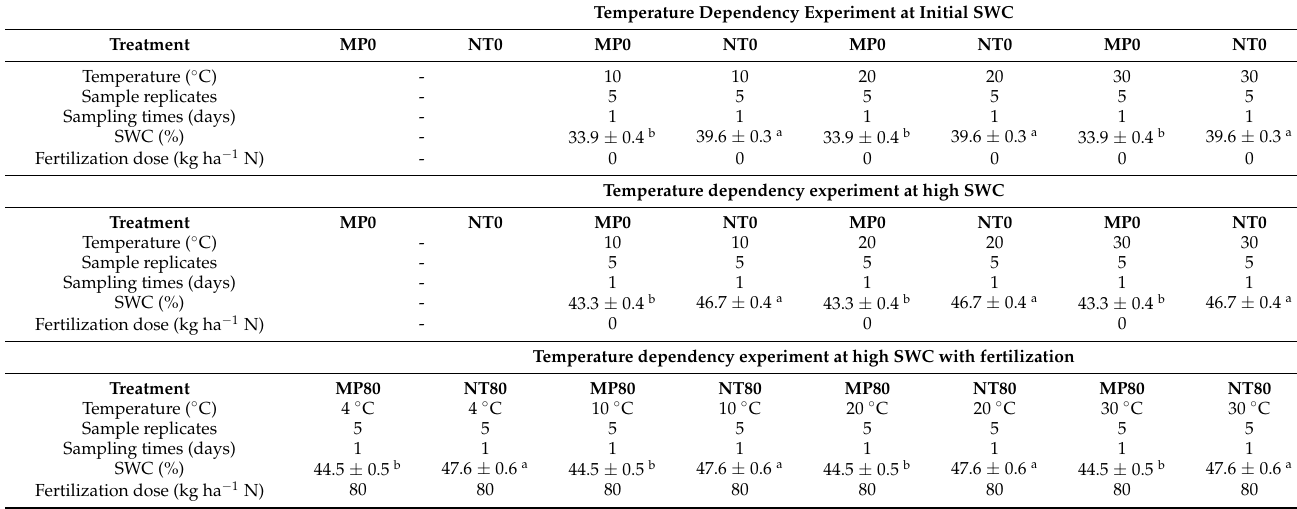
Table 3. Details of the Temperature dependency soil column experiments.